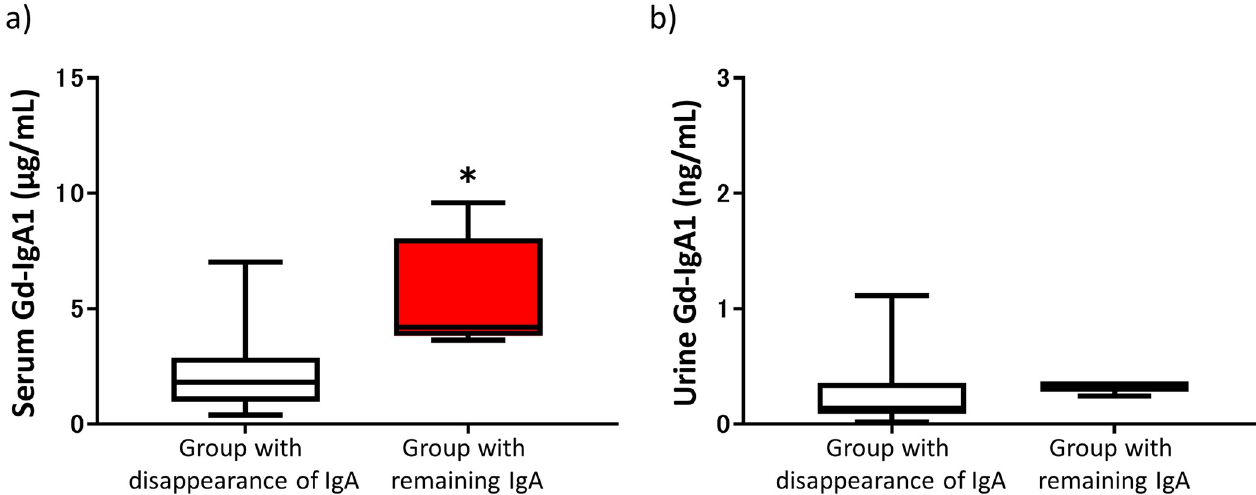
Fig 4. Serum and urinary Gd-IgA1 levels at the time of enrollment in the group in which IgA deposits disappeared and the group in which it remained. a) Serum Gd-IgA1 levels. b) Urinary Gd-IgA1 levels. Gd-IgA1, galactose-deficient IgA1; IgA, immunoglobulin A. � p < 0.05 vs group with disappearance of